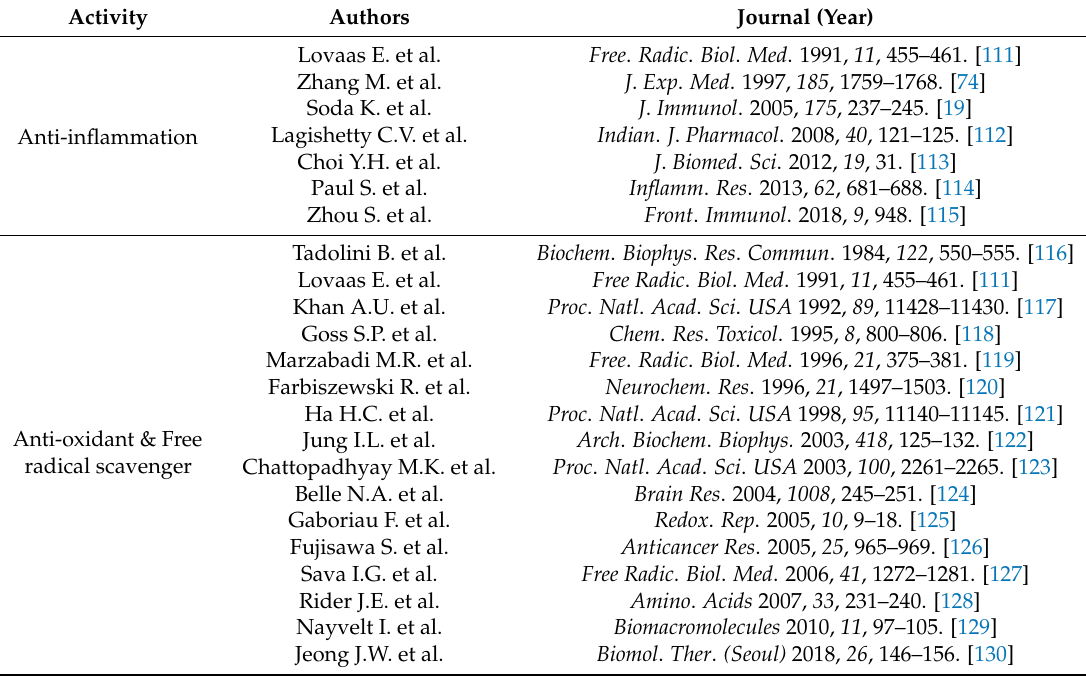
Table 1. Biological activity of